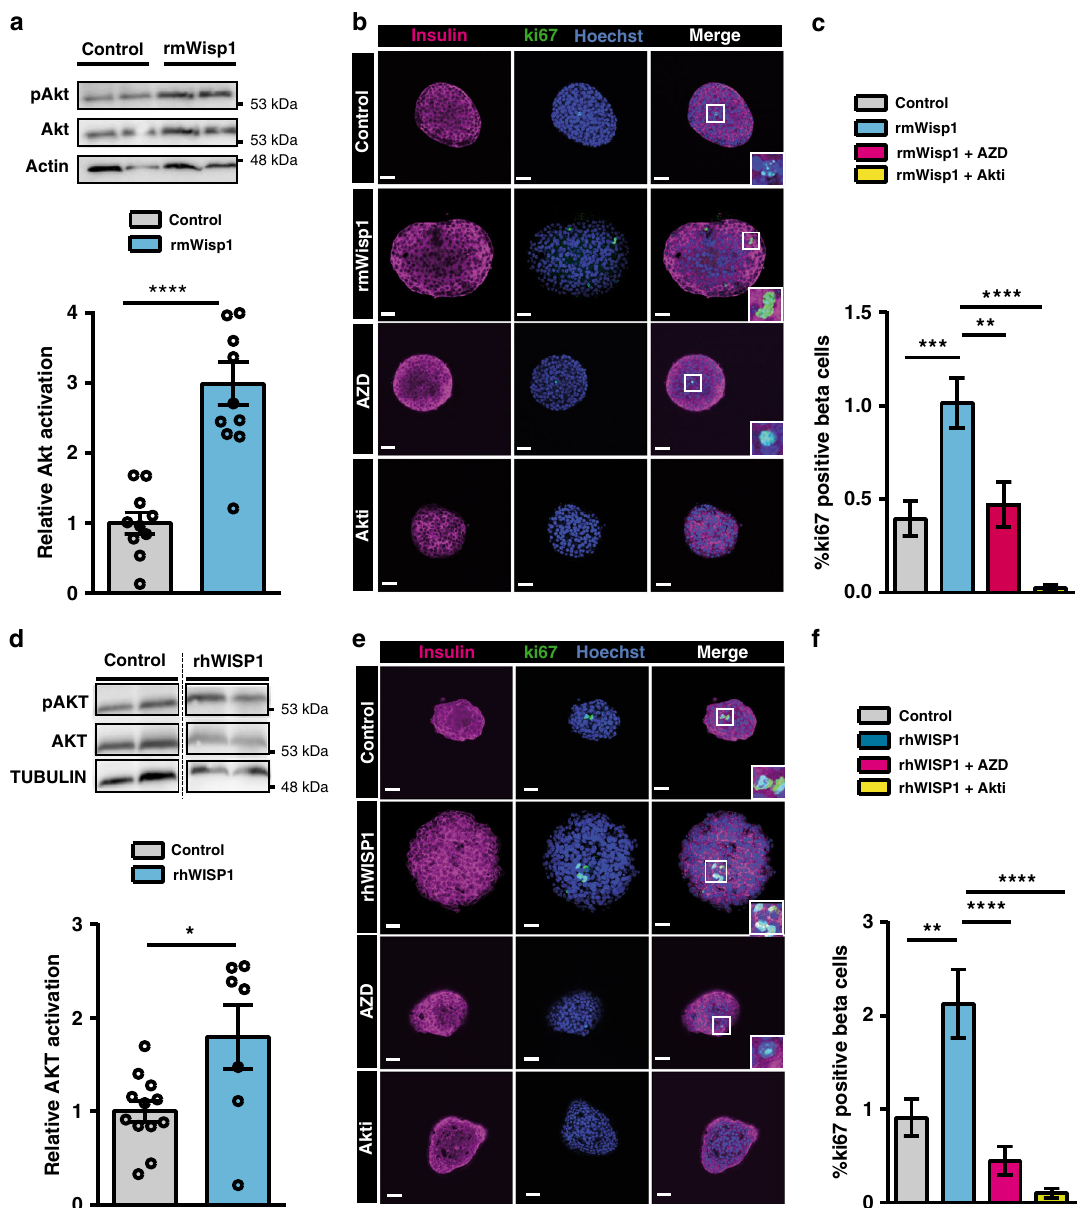
Fig. 7 Wisp1 activates Akt in mouse and human pancreatic islets. a Determination of Akt activation ( Ser473 phosphorylation) by immunoblot analysis in mouse islets incubated with recombinant mouse Wisp1 protein (rmWisp1) at 500 ng/ml for 30 min. Top: representative immunoblot image. Molecular weight markers are shown on the right. Bottom, quanti fi cation of Akt activation, expressed relative to control islets (no rmWisp1), given the value of 1 (control, in gray: n = 10; rmWisp1, in blue: n = 11, from fi ve independent experiments). b , c Beta cell proliferation in mouse islets incubated with rmWisp1 protein and Akt inhibitors. b Representative immuno fl uorescence images showing ki67 staining in green and insulin in purple. Nuclei are marked with Hoechst (blue). c Percentage of beta cells (insulin + ) that are ki67 + in islets incubated with rmWisp1protein at 500 ng/ml for 48 h alone ( n = 41 islets, blue) or with the Akt inhibitors AZD5363 ( n = 21 islets, pink) or Akti ( n = 25 islets, yellow), or left untreated (control, gray: n = 39 islets) from three different isolation experiments. d Determination of AKT activation ( Ser473 phosphorylation) by immunoblot analysis in human islets incubated with recombinant human WISP1 protein (rhWISP1) at 500 ng/ml for 15 min. Top: representative immunoblot image. Molecular weight markers are shown on the right. Bottom, quanti fi cation of AKT activation, expressed relative to control islets (no WISP1), given the value of 1 (control in gray: n = 12; rhWISP1 in blue: n = 7, from 3 donors) e , f Beta cell proliferation in human islets incubated with Wisp1 protein and Akt inhibitors. e Representative immuno fl uorescence images showing ki67 staining in green and insulin in red. Nuclei are marked with Hoechst (blue). f Percentage of beta cells (ins + ) that are ki67 + in human islets incubated with rhWISP1 protein at 500 ng/ml for 48 h alone ( n = 21 islets, blue) or with the Akt inhibitors AZD5363 ( n = 31 islets, pink) or Akti ( n = 15 islets, yellow), or left untreated (control, gray: n = 20 islets) from 3 donors. All data shown represent mean ± SEM for the indicated n . Comparisons were made using two-tailed Student ’ s t test ( a , d ) or one-way ANOVA ( c , f ). * p < 0.05; *** p < 0.001; **** p < 0.0001. Scale bars are 25 μ